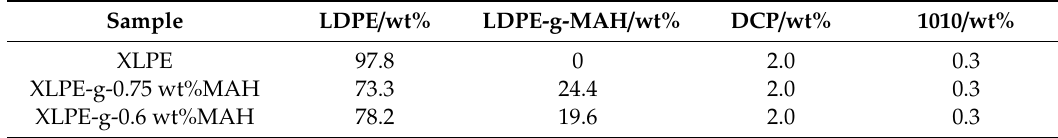
Table 1. Mixture components for preparing XLPE and XLPE-g-MAH